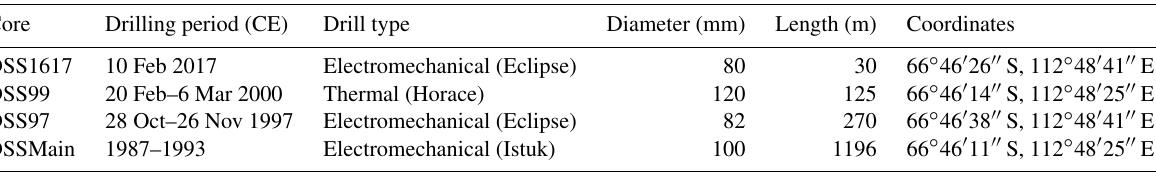
Figure 1. (a) Location of DSS ice core site on Law Dome, East Antarctica. Background image is Moderate Resolution Imaging Spectrora- diometer (MODIS) Mosaic of Antarctica (Scambos et al., 2007). (b) Relative locations of the four individual drill sites used in this record. (c) Regional context of Law Dome. Table 1. Details of the drilled cores used in this composite record. Locations of each of the individual cores are also shown in Fig. 1b.